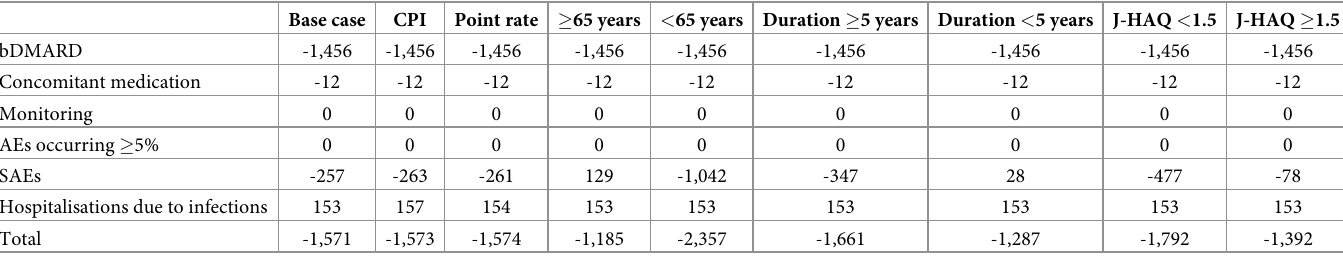
Table 6. Cost results breakdown of the model in a hypothetical cohort of 1,000 patients–per member per month (incremental costs [ABA-1L vs. TNFi-1L]).